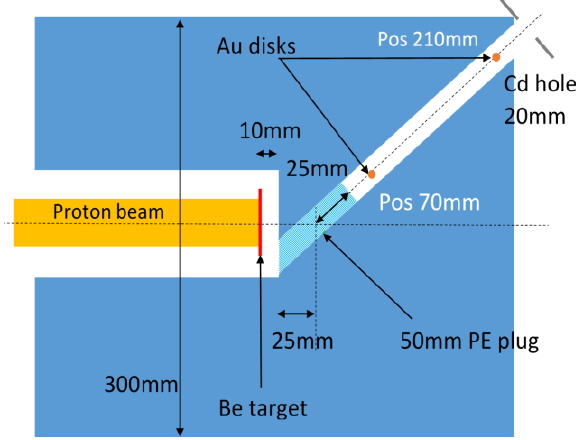
Fig. 2. Target and moderator